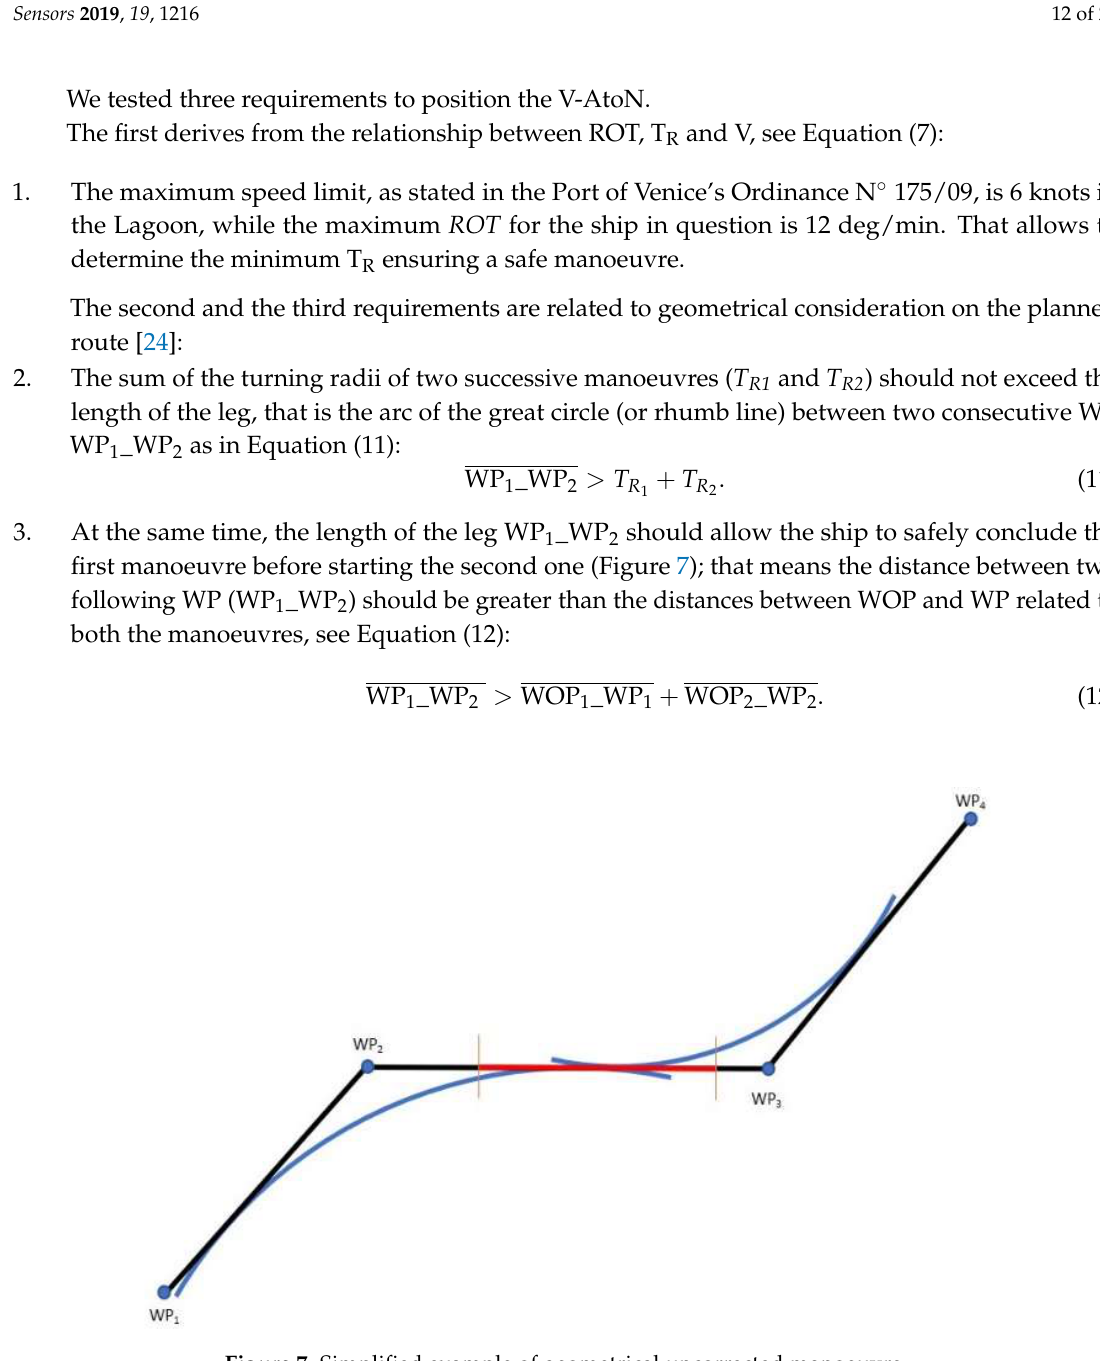
Figure 7. Simplified example of geometrical uncorrected manoeuvre.